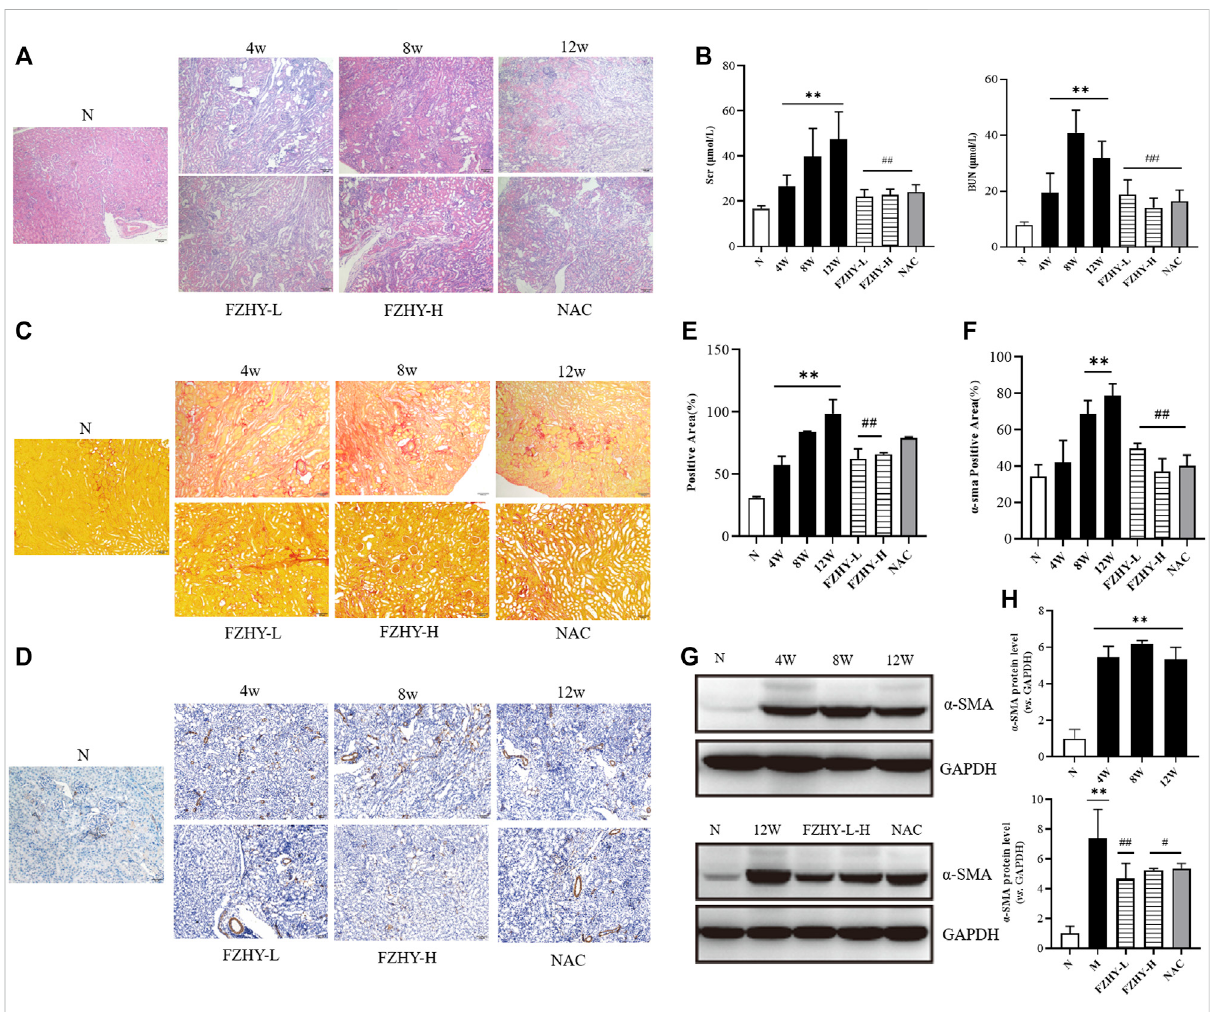
FIGURE 4 Fuzheng Huayu (FZHY) alleviates renal fi brosis induced by Aristolochic Acid I (AAI) in vivo . Dynamic experimental model mice were intraperitoneal injected with AAI (4 mg/kg body weight) twice a week and sacri fi ced at 4 weeks, 8 weeks, and 12 weeks. Pharmacodynamic experimentalmodelmicewereintraperitonealinjectedwithAAI(4 mg/kgbodyweight)twiceaweekfor12 weeks.FromfourthweekofAAIinjection, micewereintragastricallyadministeredFZHY (1.44 g/kg,2.88 g/kgbodyweight)orNAC(3.0 g/kgbodyweight)dailyfor8 weeks.Allmicewere sacri fi ced. Hematoxylin-eosin (A) staining of mouse renal tissue sections demonstrated degree of renal injury. Levels of serum creatinine and blood urea nitrogen (B) were used to detect renal function. The collagen deposition was shown by using Sirius Red staining (C) . Signi fi cant renal collagen deposition was observed in mice after AAI administration, which was then reduced by using FZHY or NAC (E) . IHC (D,F) and WB (G,H) analysis of a-SMA showed the degree of renal fi brosis, which increased after AAI injection and alleviated by FZHY (Figures 4F,H). FL, Fuzheng Huayu low-dose; FH, Fuzheng Huayu high-dose. Bar = 100 μ m; * p < 0.05, compared with normal group; ** p < 0.01, compared with normal group; # p < 0.05, compared with model group; ## p < 0.01, compared with model